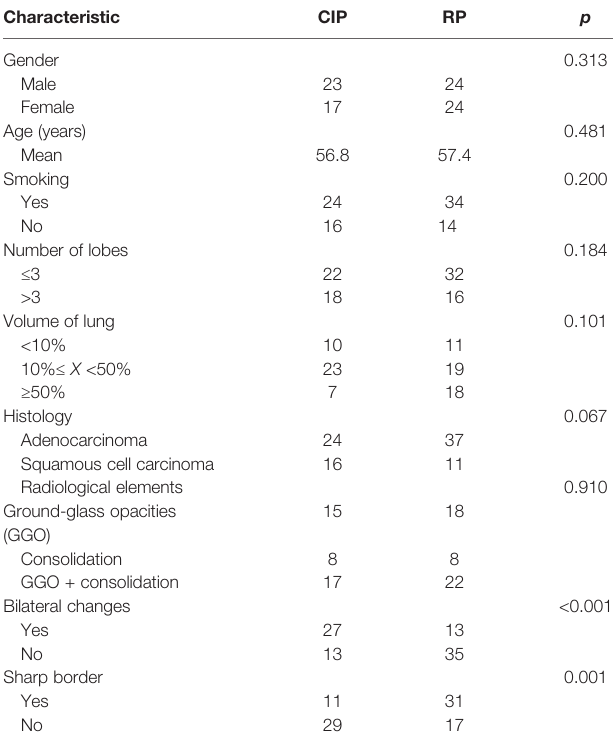
TABLE 3 | Clinical and radiological parameters of patients with checkpoint inhibitor- related pneumonitis (CIP) and radiation pneumonitis (RP) in the training dataset.